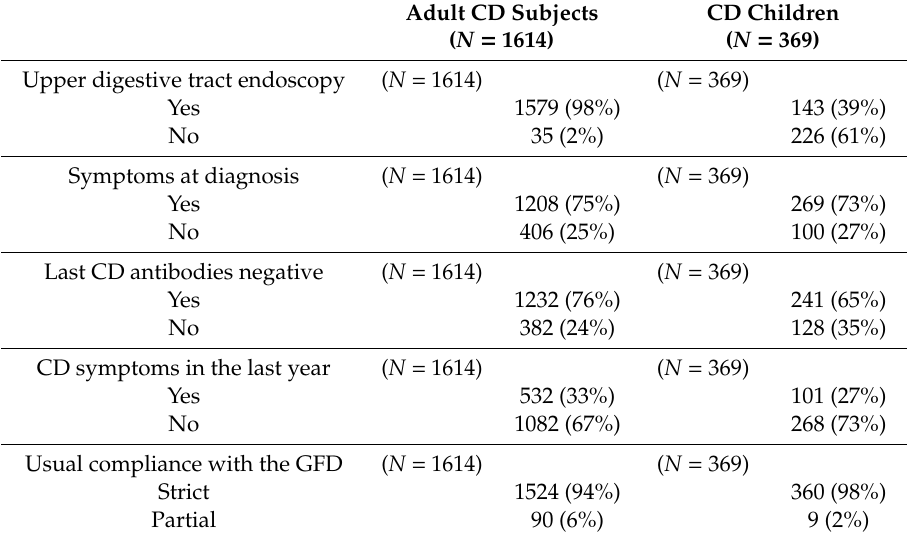
Table 2. Data about CD diagnosis and